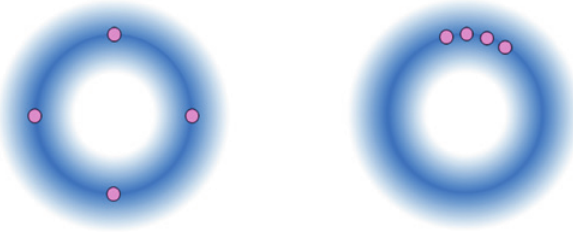
Figure 8: Diagrams showing nanoparticles trapped in the cross- section of a Laguerre-Gaussian